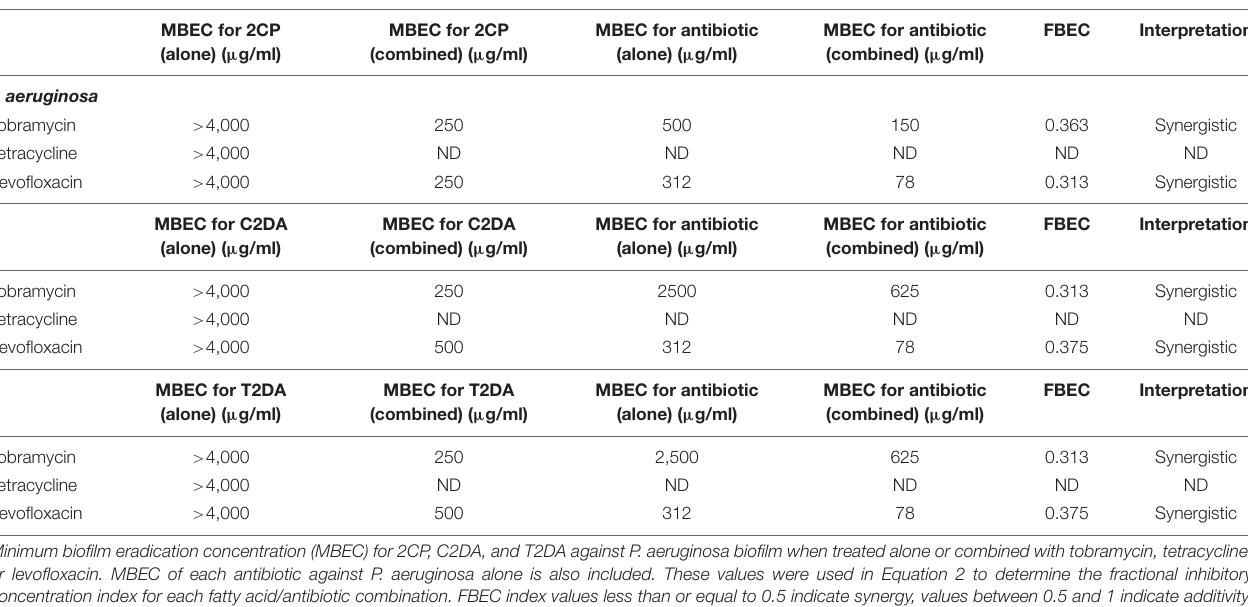
FBEC Interpretation